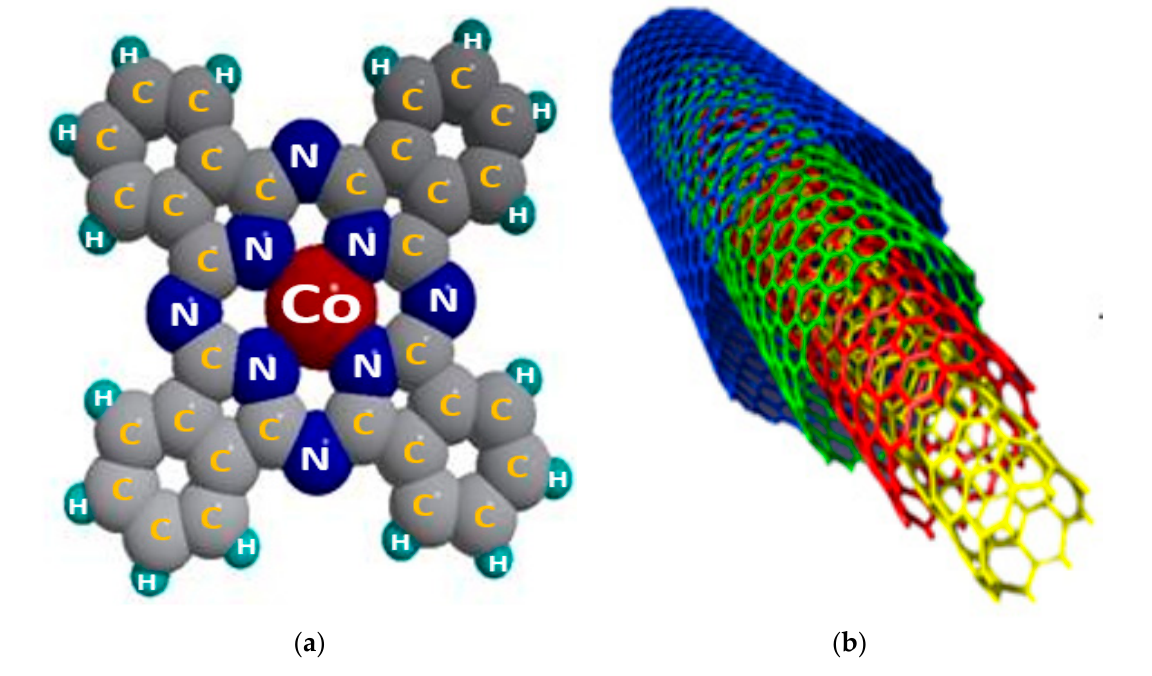
Figure 1. Diagram of ( a ) CoPc and ( b ) MWCNTs.